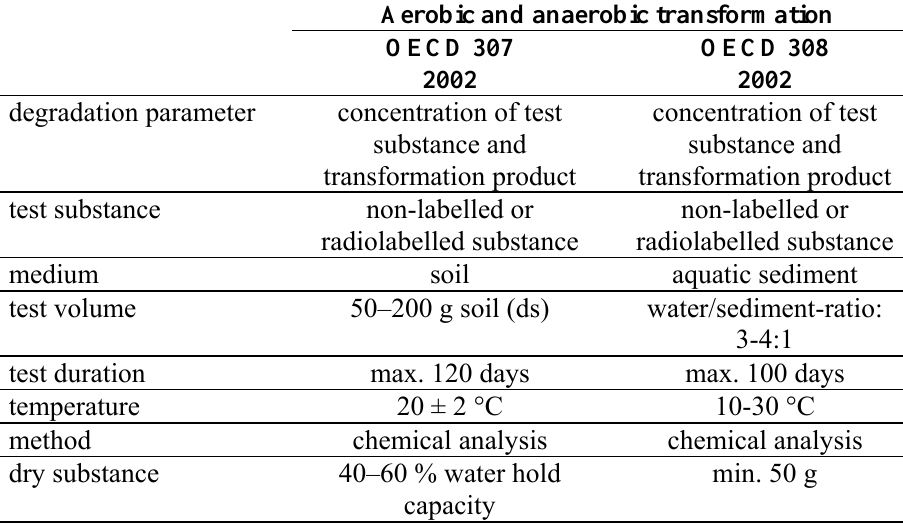
Table 4 . Standard simulation tests for anaerobic biodegradation [45,46].